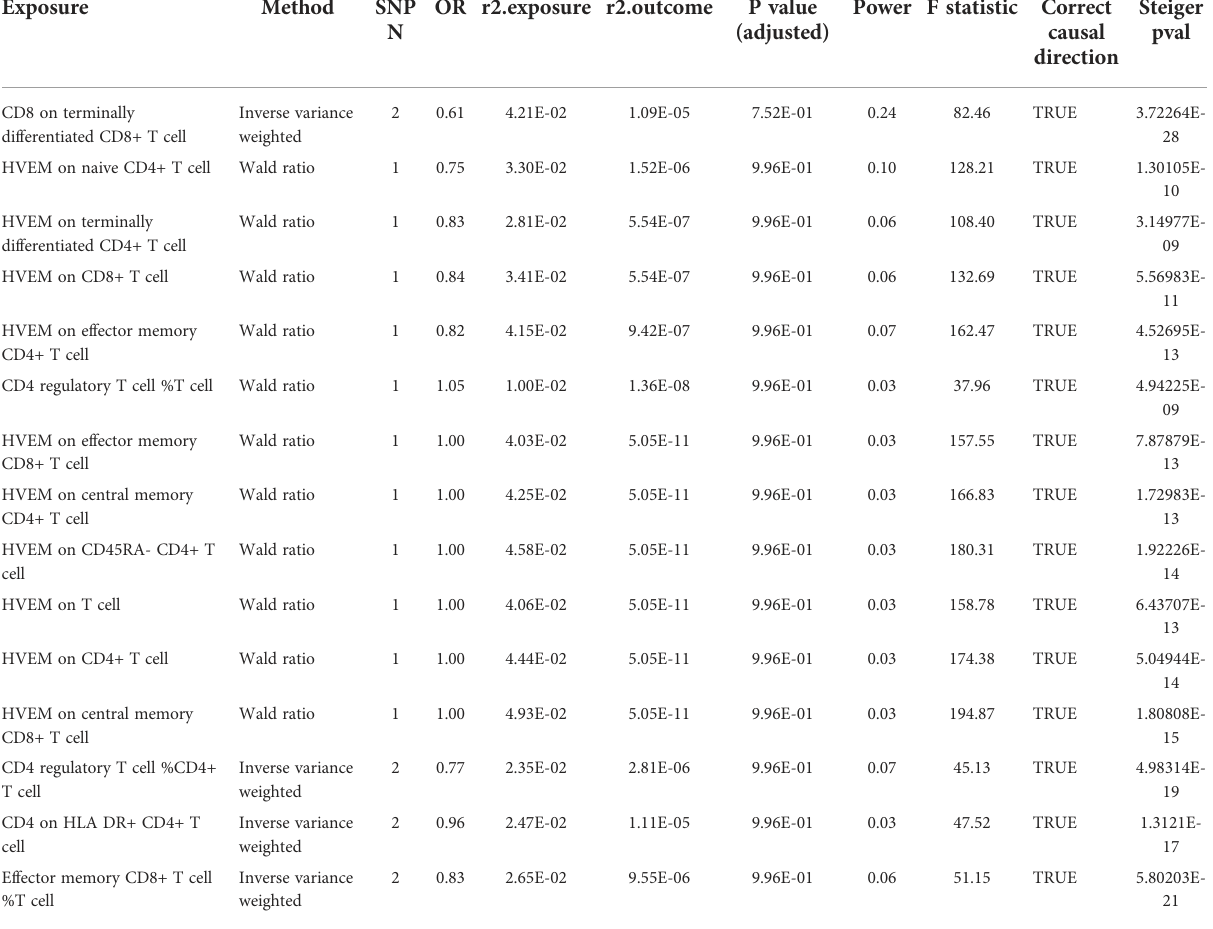
TABLE 4 Detailed MR result in the secondary analysis (UK biobank).